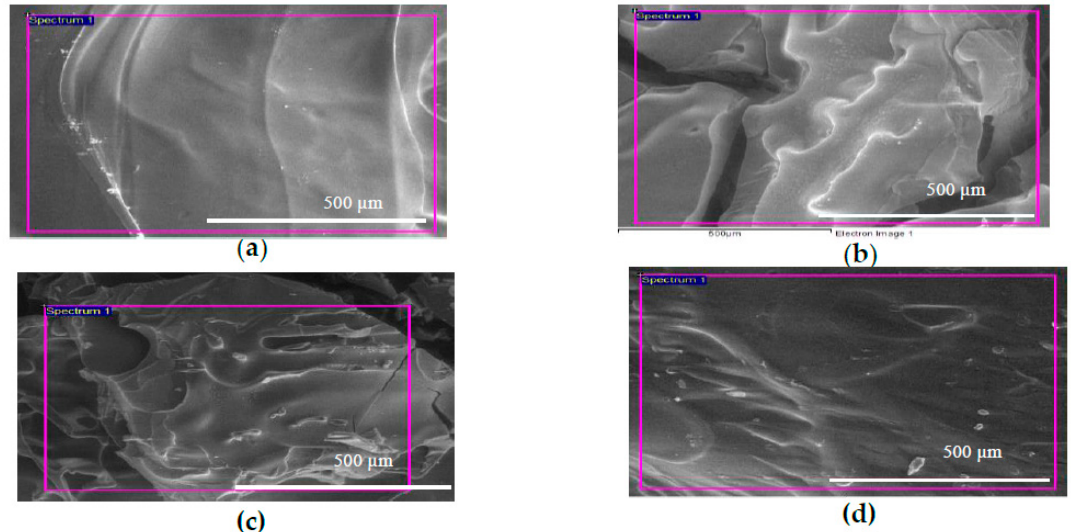
Figure 2. FESEM image of ( a ) pristine GTA crosslinked CS scaffold ( b – d ) CS-GO2, CS-GO4, CS-GO6, GTA crosslinked CS scaffolds dispersed with GO at 2, 4, and 6 wt % respectively.